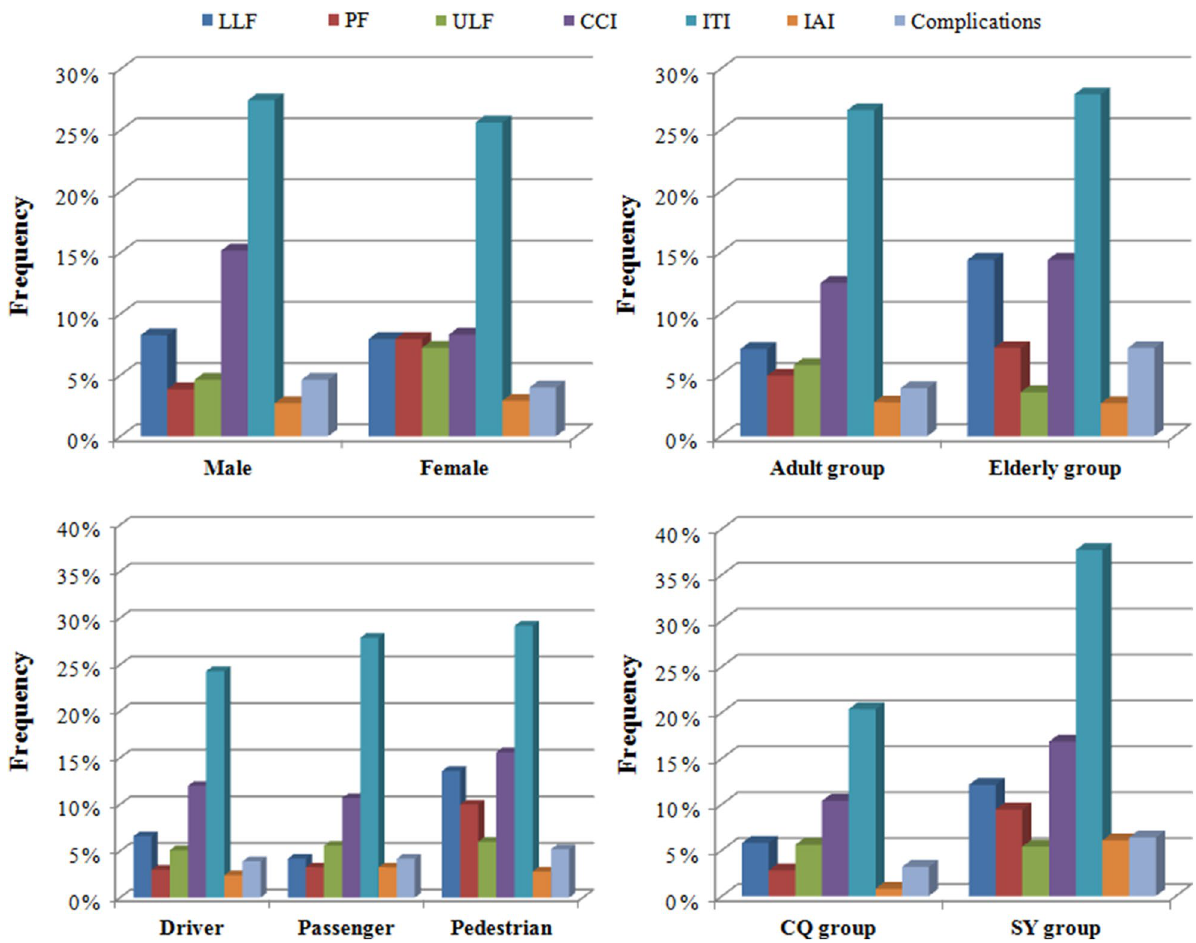
Figure 2. Distributions of associated injuries and complications according to different